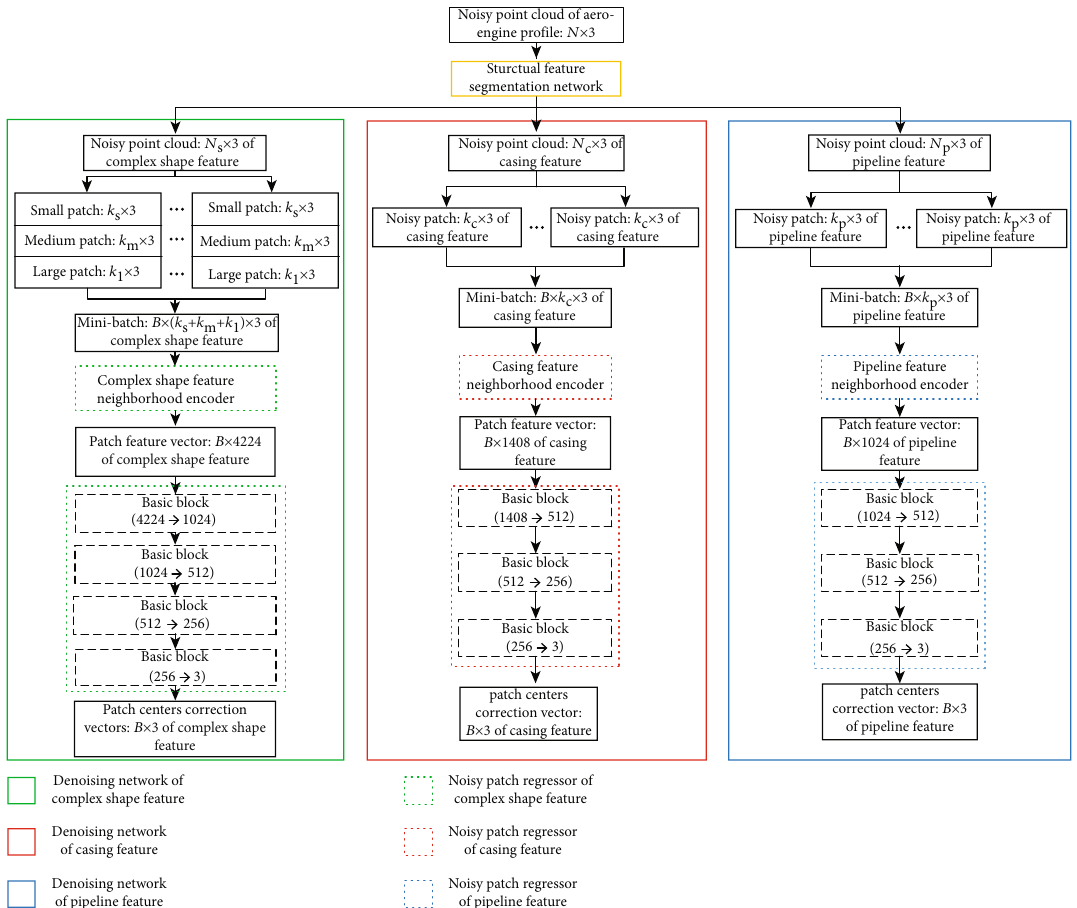
Figure 3: SFP-PDNet